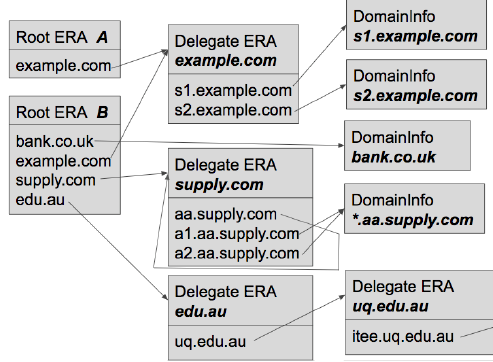
Figure 2: Root and Delegate ERAs and Domain